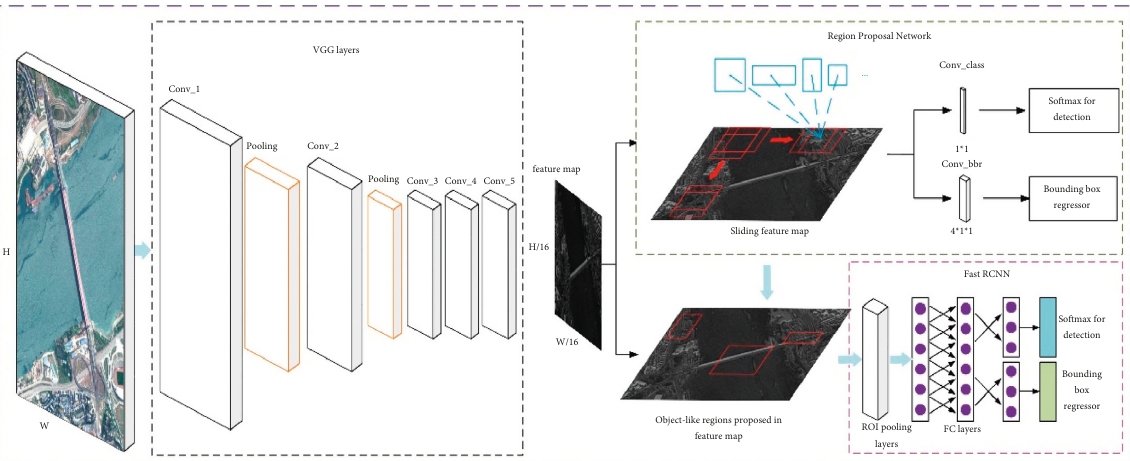
Figure 1: The architecture of Faster R-CNN.